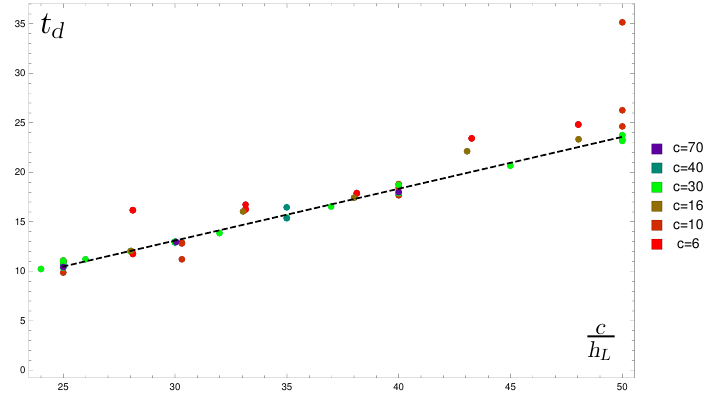
(cid:25)c with an empirical 6 h L (cid:17) re (cid:0) it . Note that the data (cid:0)